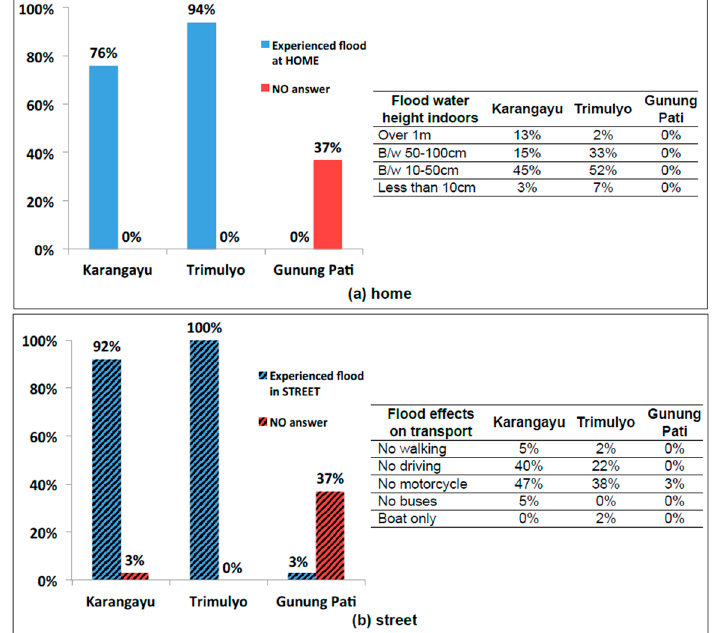
Figure 4. Resident flooding profile as percent of participants experiencing flood ( a ) at home and ( b ) in the neighbourhood streets during the worse flood event, with respective tables of flood water height indoors and flood effects on transportation.